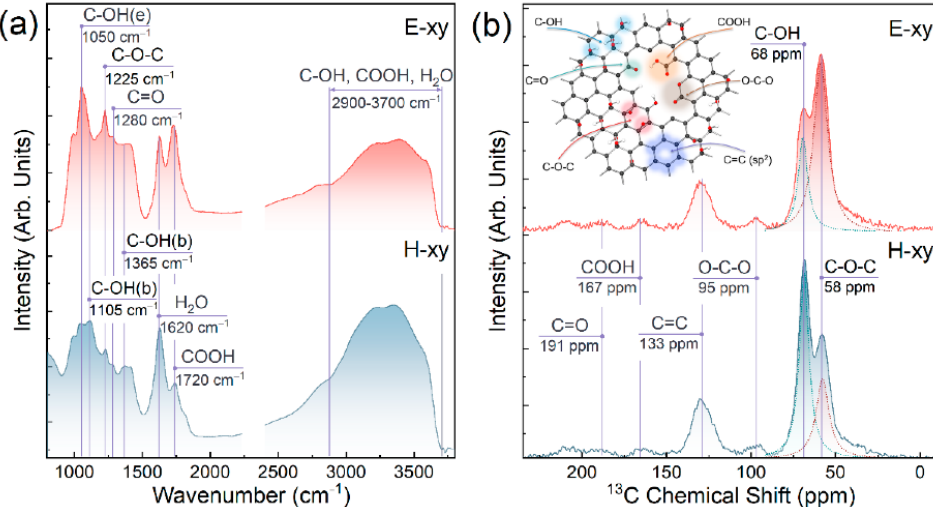
Figure 4. ( a ) Fourier −transformed infrared (FT− IR) spectra and ( b ) solid− state 13 C nuclear magnetic